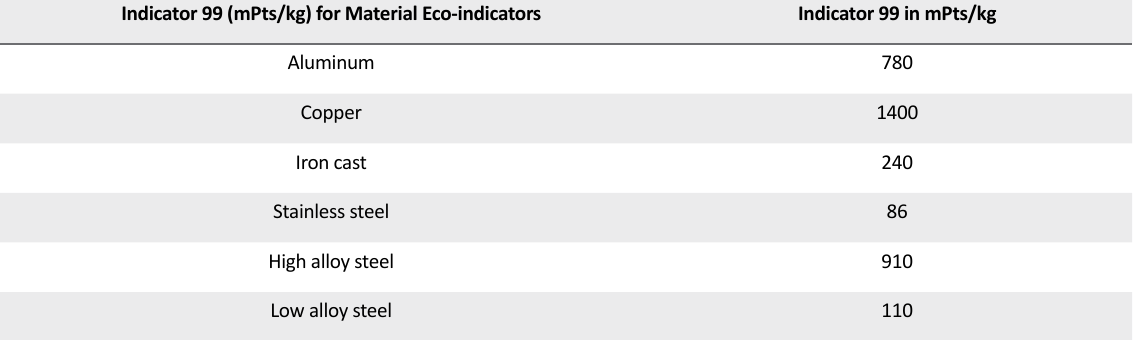
Table 5. Environmental indices for different materials